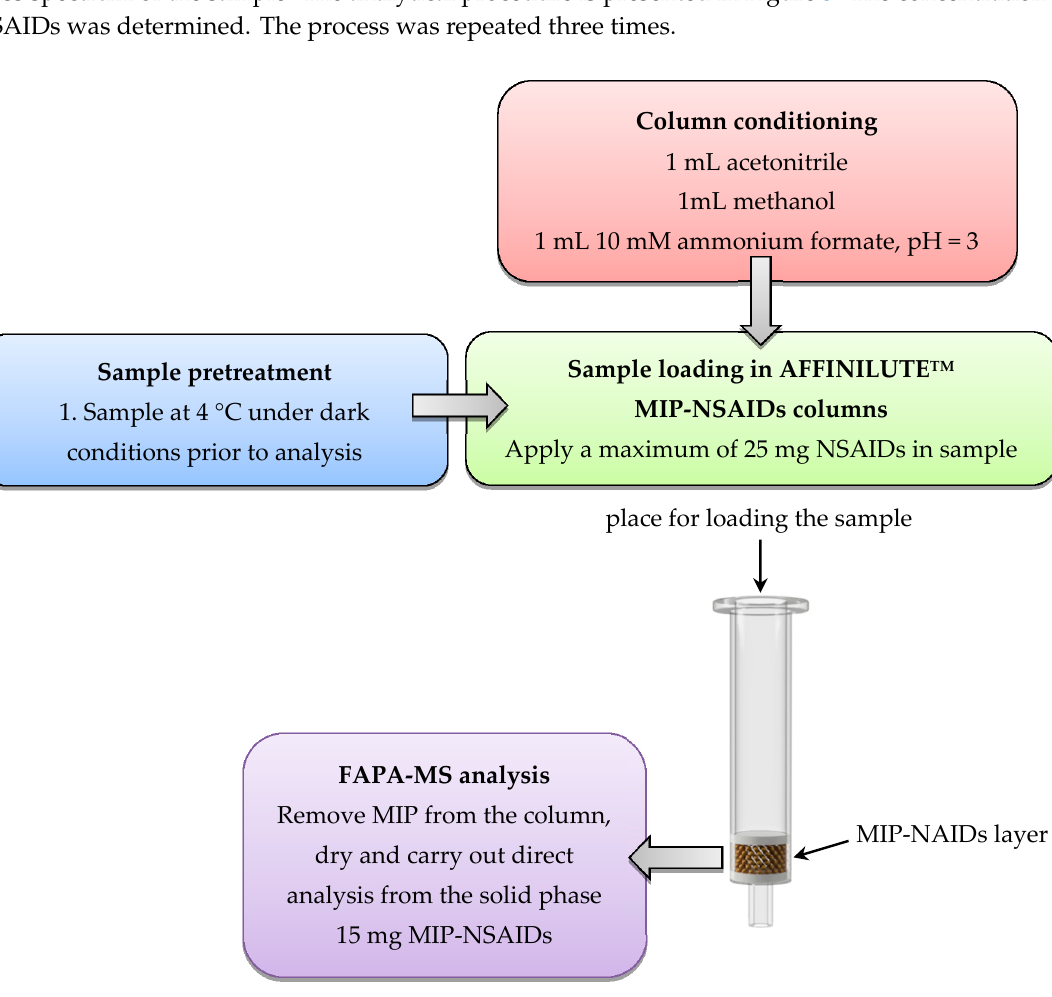
Figure 3. The analytical procedure for the determination of NSAIDs using an AFFINILUTE TM MIP ‐ NSAIDs column and FAPA ‐ MS.